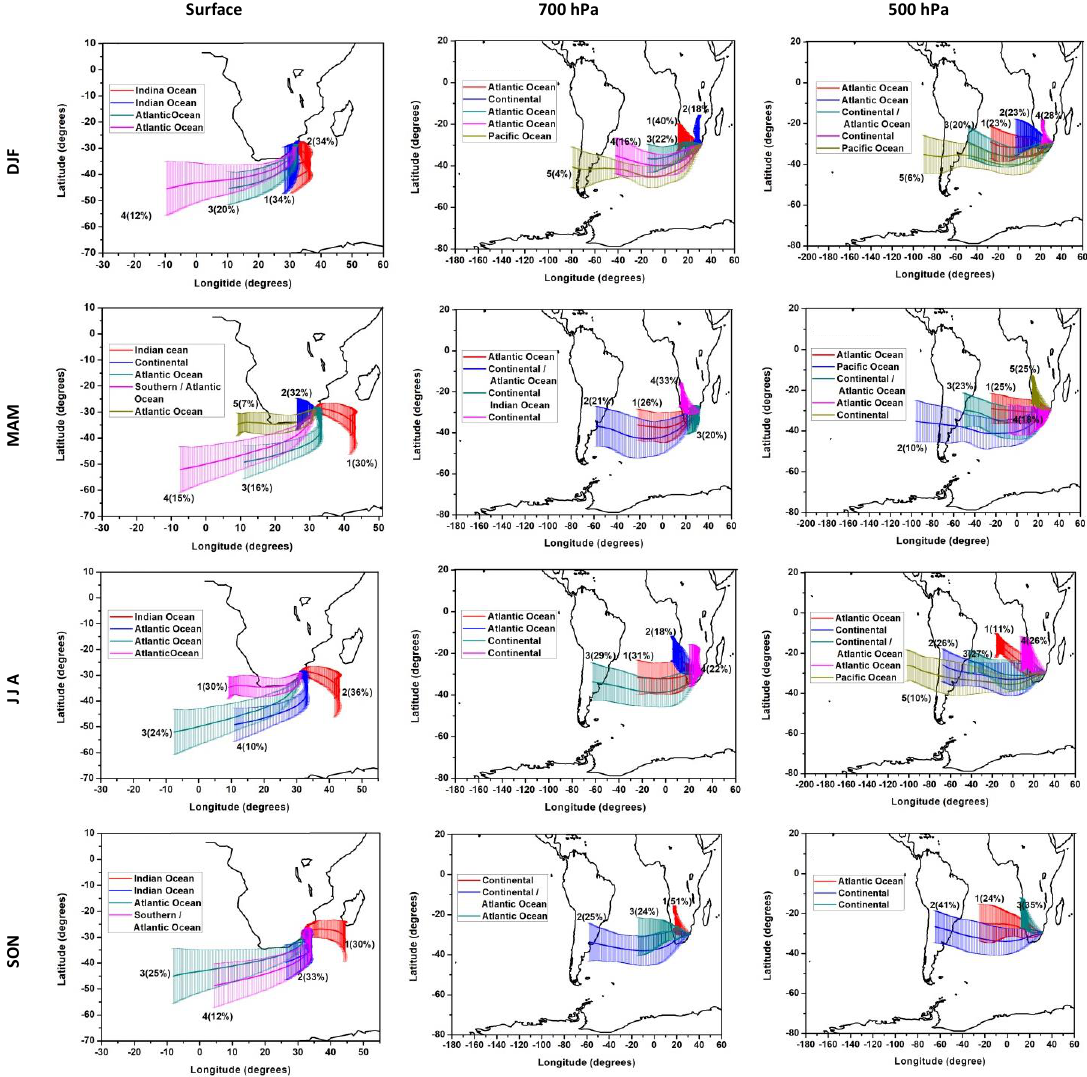
Figure 8. Seasonal 5-day backward trajectories illustrating air transport with its frequency impacting on CO 2 mixing ratios at the surface, above 3400 and 5500 m stable layers at East Coast of South Africa area. From the top to the bottom row is the seasonal change from DJF to SON, while the left, middle and right columns represent atmospheric layers at the surface, above 3400 and 5500 m stable layers, respectively.